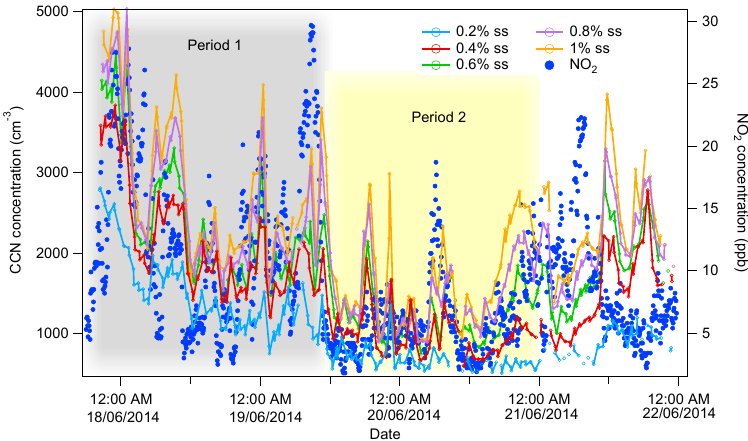
Figure 1. Cloud condensation nuclei (CCN) concentration levels at the measured supersaturations during the measurement period. As a reference for the influence of local sources, the NO 2 concentration levels are also shown. The two shaded areas represent the different periods of high and low CCN levels, respectively.